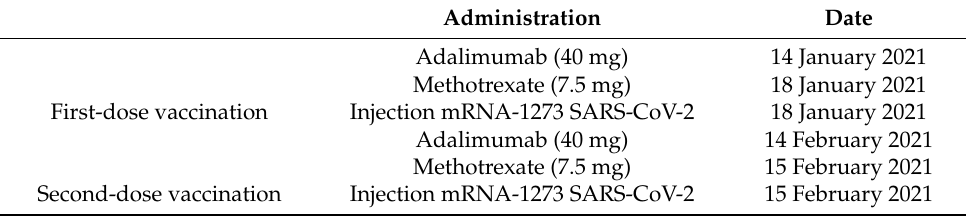
Table 1. Dates of administration of the vaccine and of the methotrexate–adalimumab combination therapy.